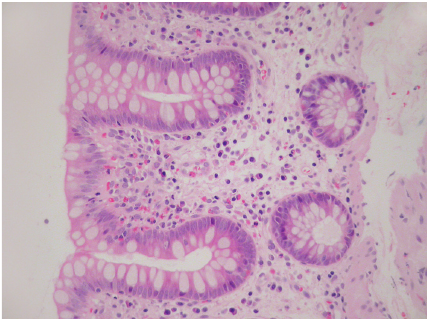
F 2: Proximal colon showing 20–25 eosinophils/HPF within the lamina propria. is is not a pathological